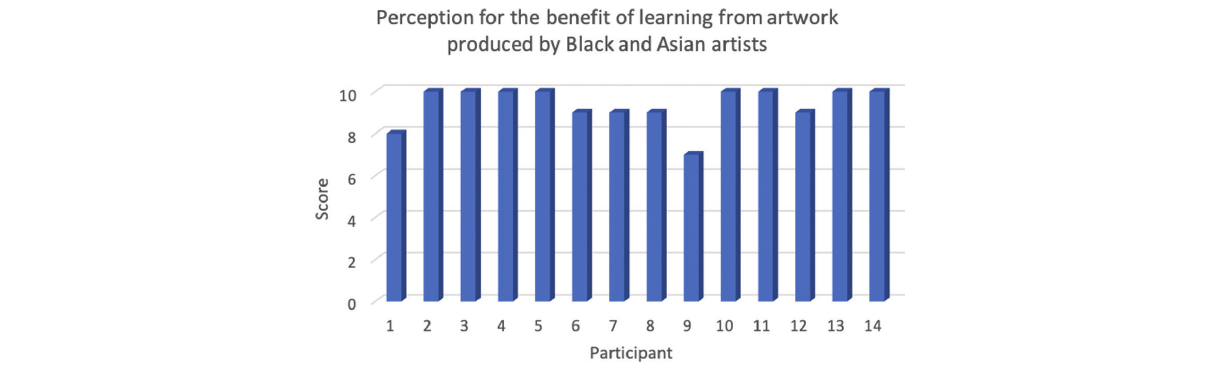
Figure 21. Perception of the content learnt from artwork produced by Black and Asian artists (Source: Author,